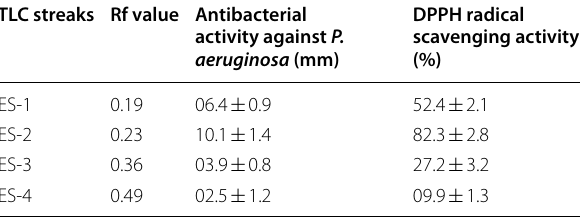
Table 4 Rf values and their corresponding bioactivites of active fraction of S. maritima after preparative TLC TLC streaks Rf value Antibacterial activity against P.